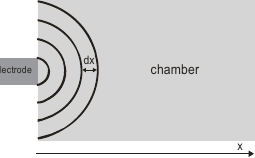
Fig.17: Simple approach for calculating the spreading resistance of a small disk shaped